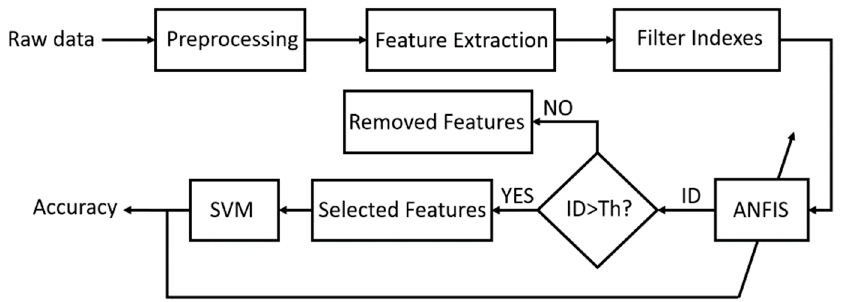
Figure 1. Scheme of the proposed approach procedure; ID and Th mean Importance Degree and its Threshold, Threshold, respectively.